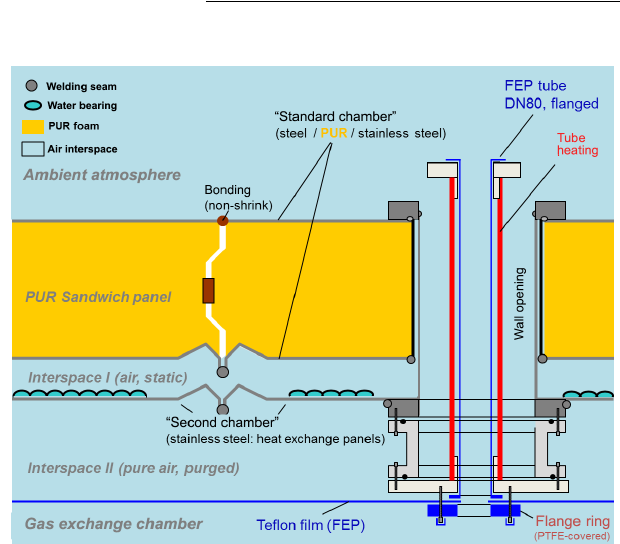
Figure 2. Horizontal cross-section through the multi-layered walls of the triple-cage plant chamber system, including the double- walled wall opening and flanges for the transfer tube to SAPHIR.